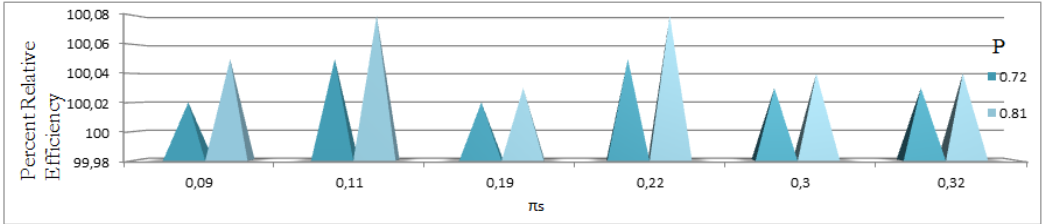
ˆ π (under optimum allocation) with respect to ST